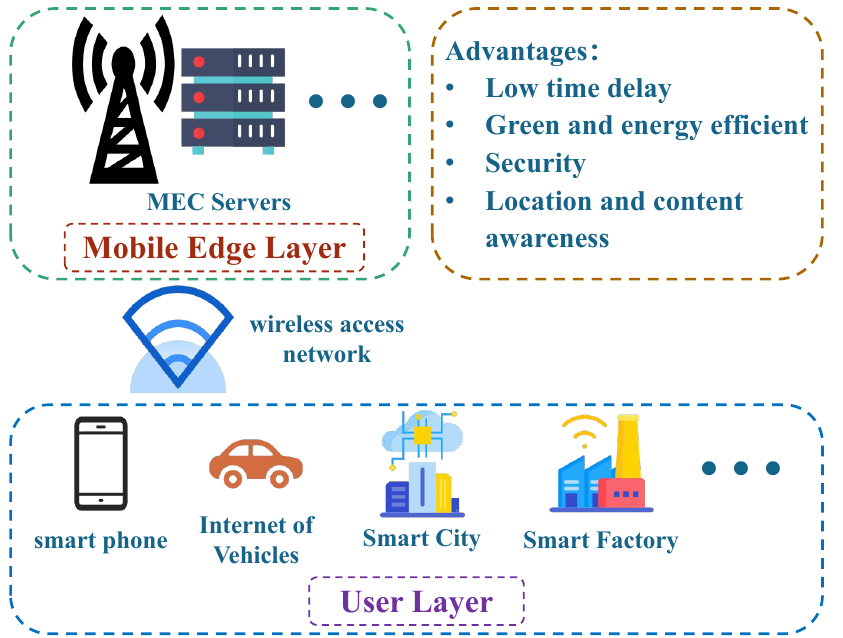
Figure 2. Architecture, applications, and advantages of